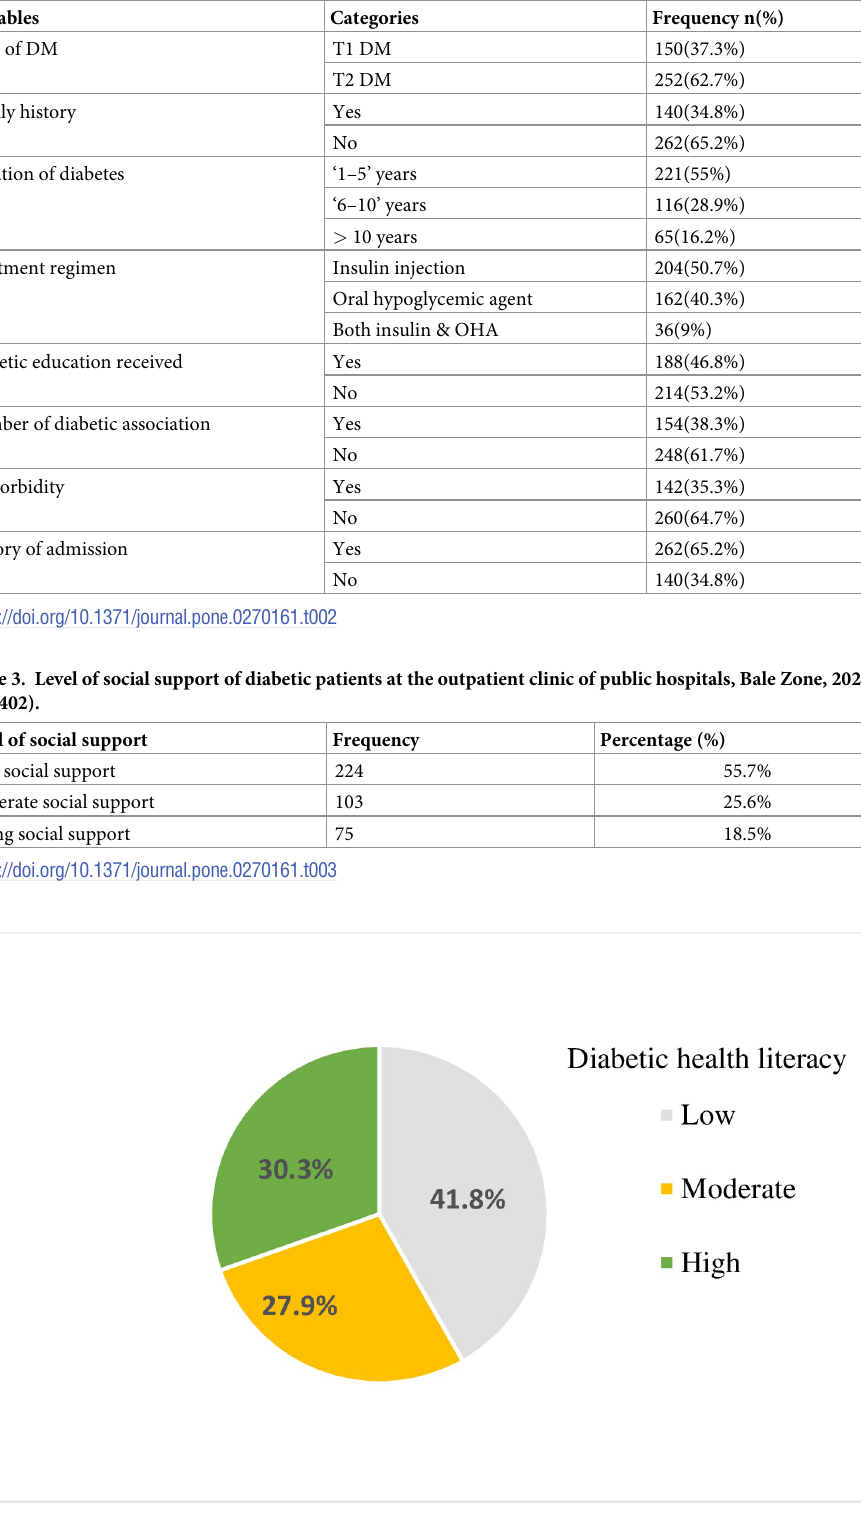
Fig 2. Magnitude of diabetic health literacy of diabetic patients at the outpatient clinic of public hospitals, Bale Zone, 2021 (n = 402).